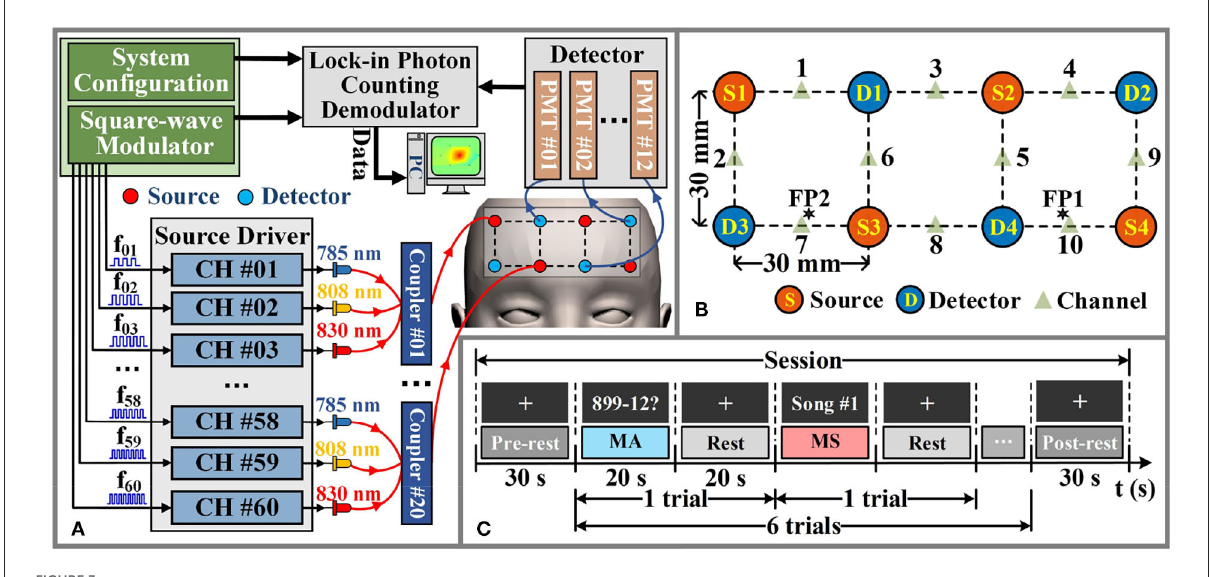
FIGURE3 Hardware instruments and experimental paradigms for in-vivo experimental data acquisition. (A) The schematic diagram of the fNIRS-DOT instrument. (B) Experimental source and detector configuration. (C) Experimental paradigm of MA and